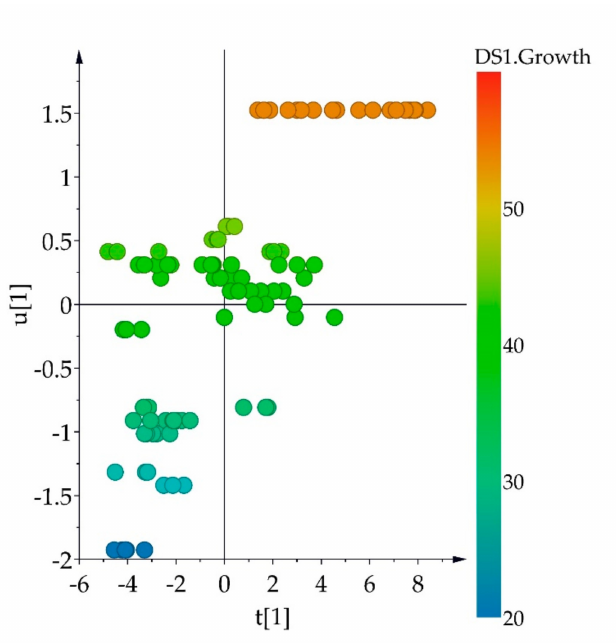
Figure 3. Orthogonal partial least squares analysis of high performance thin layer chromatography (HPTLC) dataset of methanol extracts of fungal endophytes grown on potato dextrose agar and their colony size. t[1] = PC1 of X-variables of HPTLC data; u[1] = PC1 of Y-variable (colony